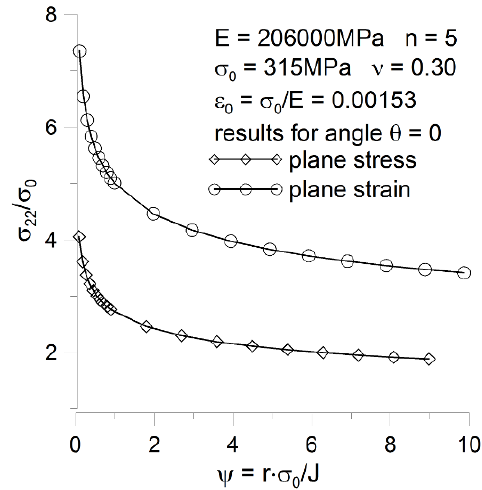
Figure 1. Thecrackopeningstressdistributionforelastic-plasticma- terials, obtained using the HRR solution.